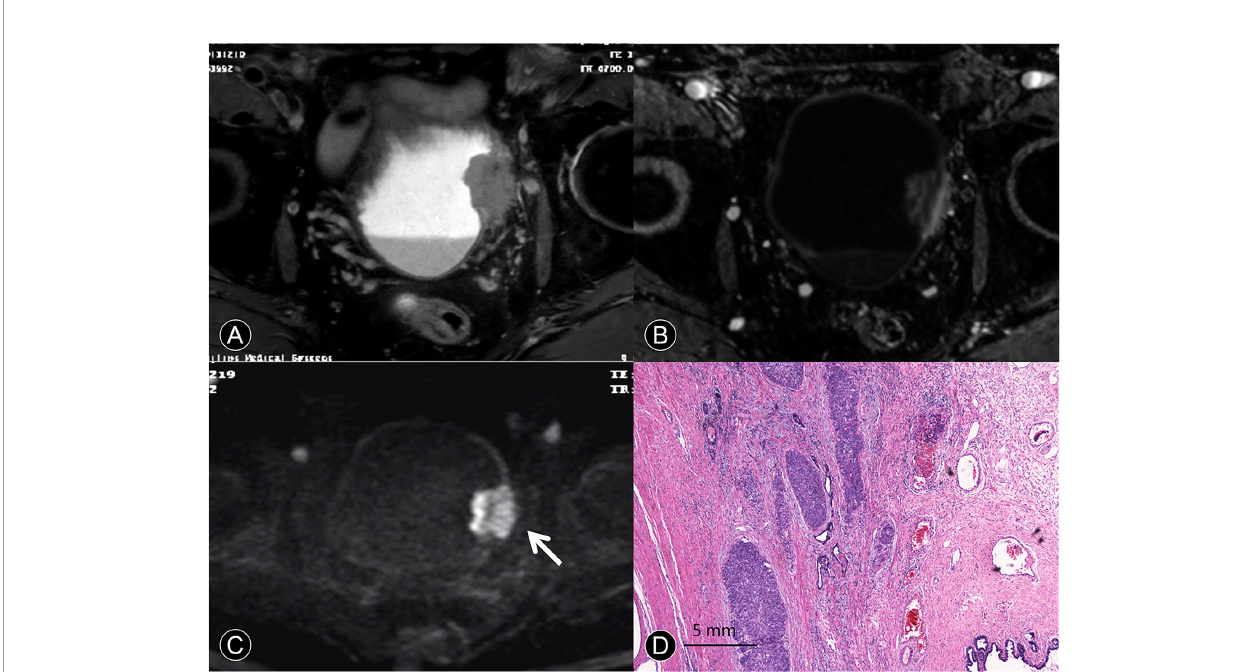
FIGURE 4 | MR images of a 63-year-old man with pT4a urothelial carcinoma. (A) The transverse T2 SPAIR image shows large nonpapillary cancer on the deformed muscle layer. The SI of the muscle layer at base of the cancer is elevated, and there is clear evidence of perivesical invasion. (B) The DCE image of the axial section leftward to the wall of the bladder does not depict cancer contour because microvessels surrounding the cancer are also enhanced. (C) The transverse DW image shows a large cancer with an irregular margin spreading toward the surrounding fat tissue (arrow). (D) A photomicrograph of the specimen shows papillary cancer invading the muscular layer and prostate (Hematoxylin-eosin staining; original magni fi cation, ×40).